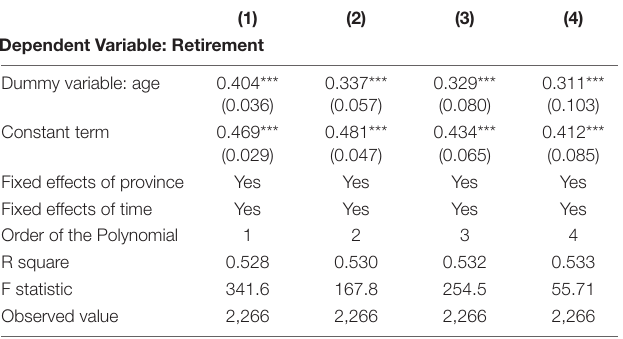
TABLE 4 | The second-stage regression: effects of retirement on health and lifestyle